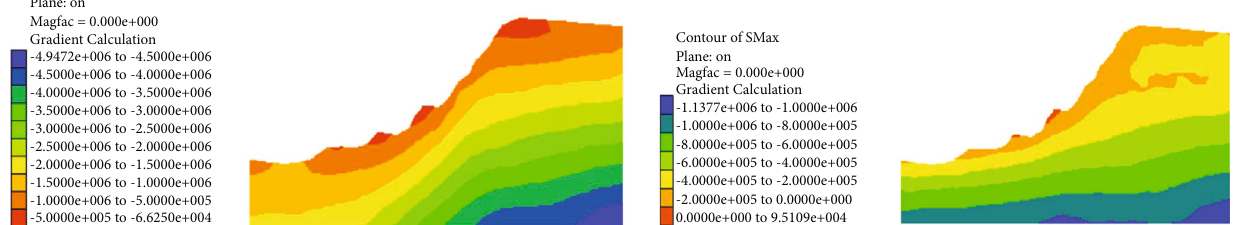
Figure 13: Cloud chart of the maximum and minimum principal stress of x = 350 section.